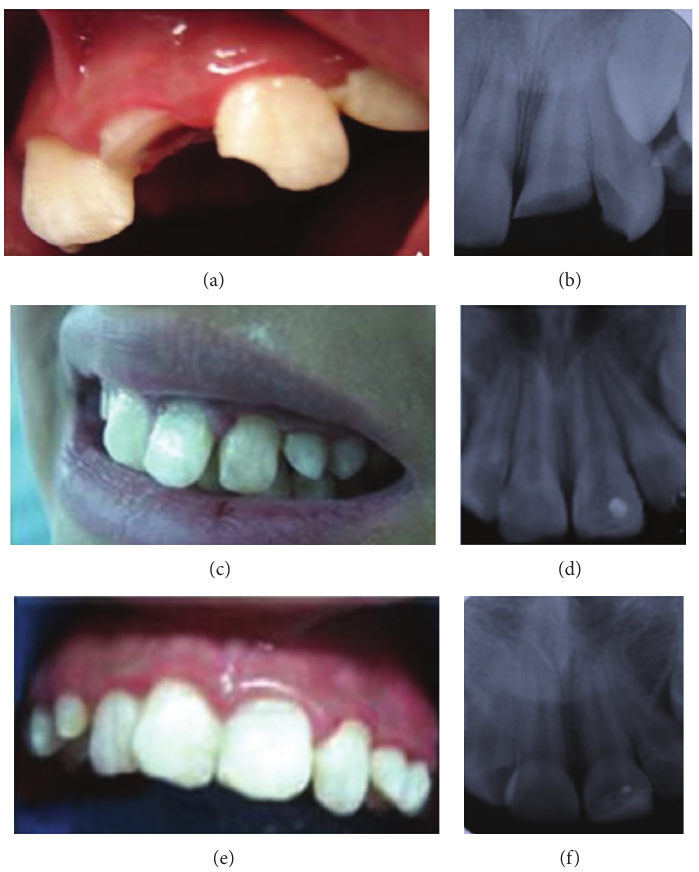
Figure 1: (a) Initial clinical image of patient 4 h after trauma with complicated crown fracture in maxillary left central incisor, with ulcerated and exposed pulp, and enamel crown fracture in left lateral incisor. (b) Initial radiograph showing loss of dental structure, complete root development, closed apices, normal periodontal ligament, and absence of root or alveolar bone fractures. (c) Resin reconstruction and reattachment of tooth fragments after treatment. (d) Posttreatment radiograph showing indirect pulp capping with resin reconstruction in the maxillary left lateral incisor and pulpotomy with reattachment of the dental fragments in the left central incisor. (e-f) Clinical and radiographic examinations 6 months after trauma. Patient showed no periodontal or periapical pathology, nor pulpal signs or